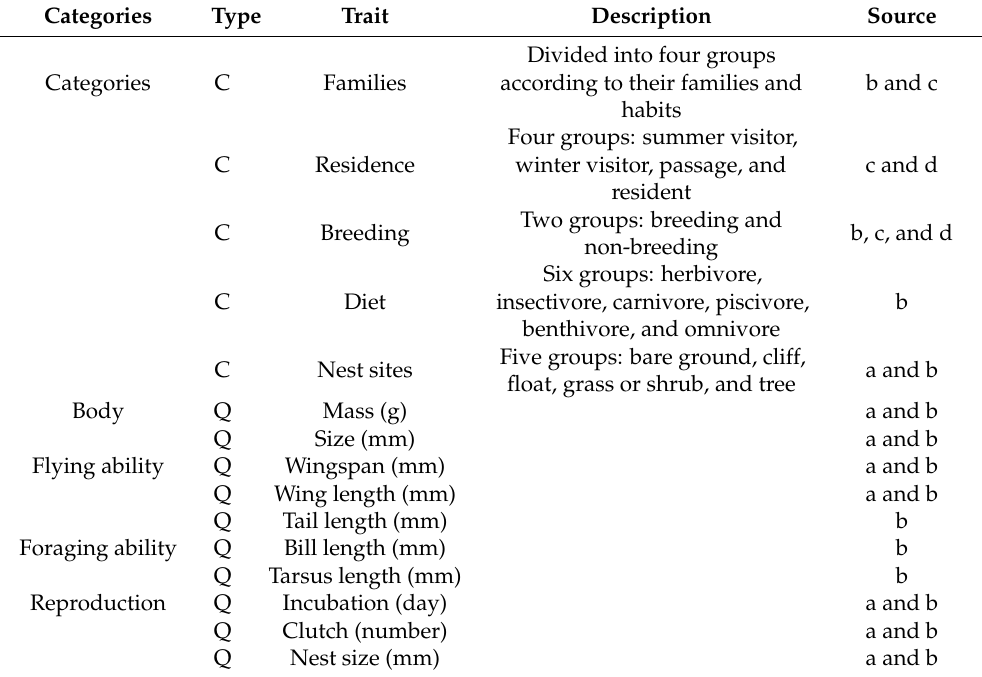
Table 1. Detailed information on the waterbird variable traits and their descriptions. Categorical variables (C) and quantitative variables